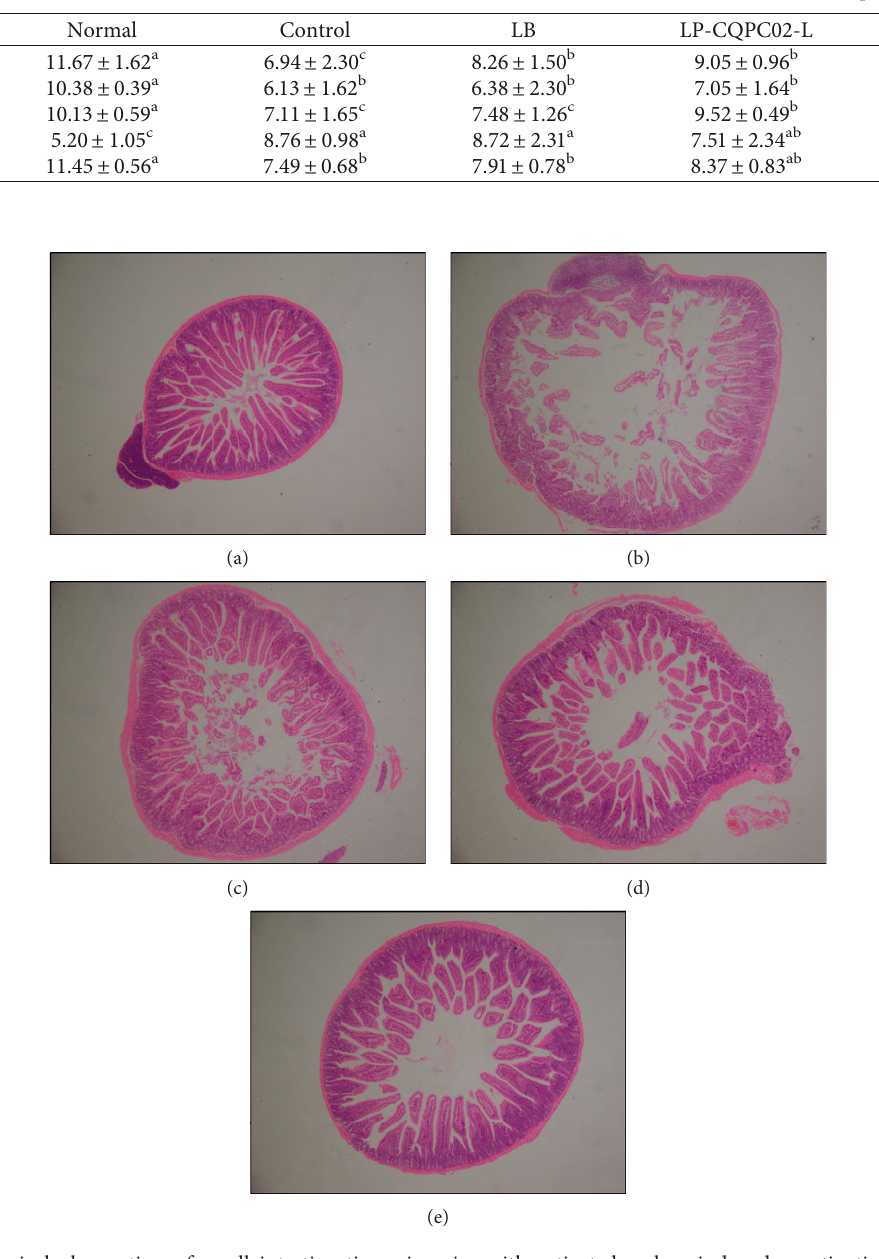
Table 3: MTL, Gas, ET, SS, and AChE serum levels in mice with activated carbon-induced constipation.